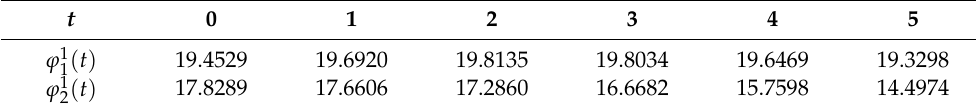
Table 6. Optimal subgame payoffs the players get for economic